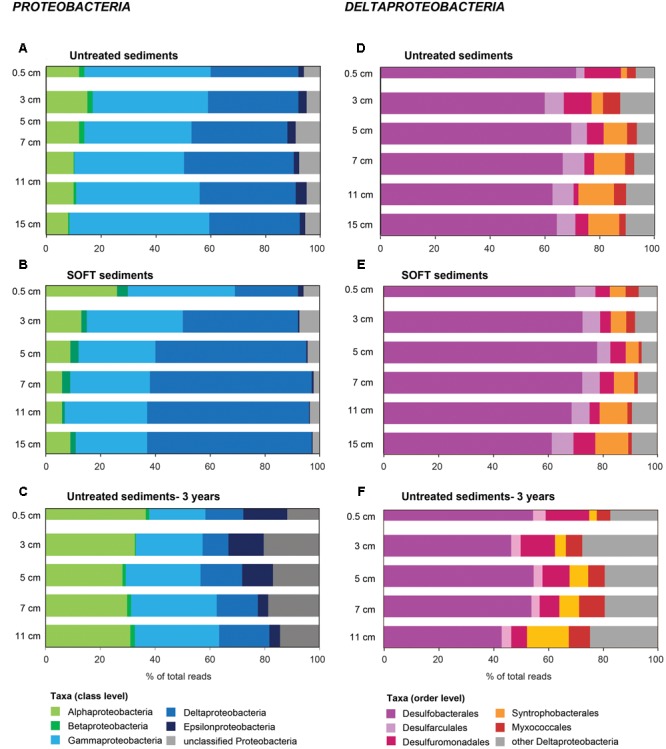
Community composition of (A–C)
Proteobacteria and (D–F)
Deltaproteobacteria in untreated (A,D), untreated-3 years (C,F) and SOFT (B,E) sediments from Caspian Sea based on 16S rRNA gene sequencing. Petroleum flow-through resulted in a community shift in SOFT sediments toward a higher percentage of deltaproteobacterial sequences. Storage of untreated sediments for 3 years at 0°C in the dark (C,F) resulted in a shift toward Alphaproteobacteria and Epsilonproteobacteria and a decrease of Deltaproteobacteria indicating that long-term storage did not favor the growth of deltaproteobacterial, hydrocarbon-degrading sulfate reducers identified in this study.